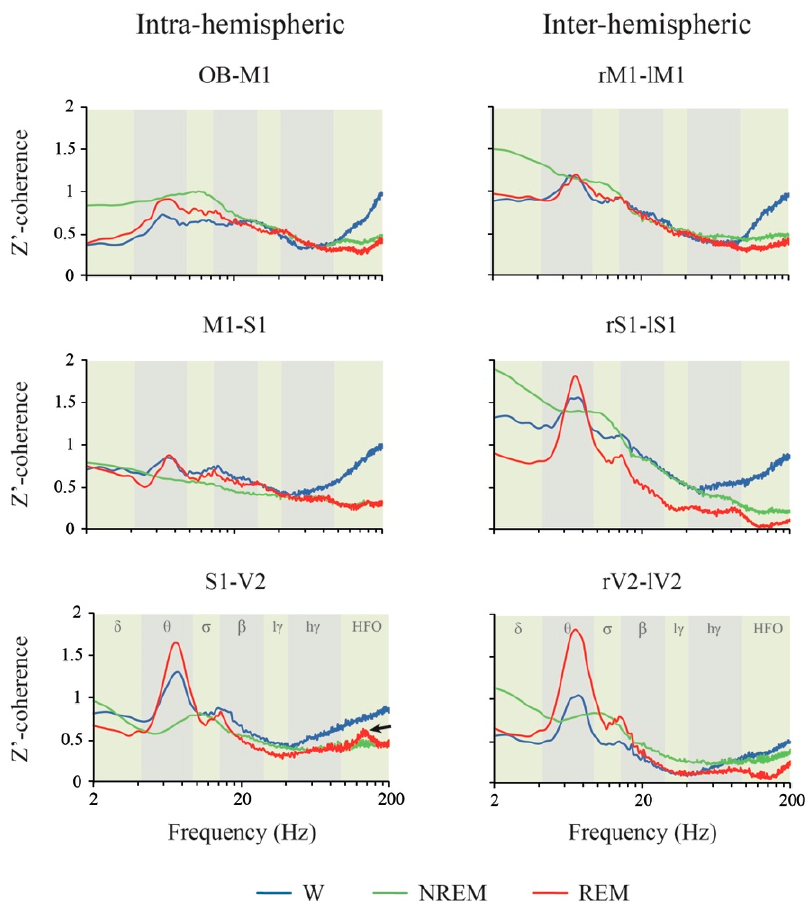
Figure 6. Z’-coherence. Mean z’-coherence profile of the inter-hemispheric and intra-hemispheric derivations (between adjacent areas) during wakefulness (W), NREM and REM sleep in the light phase ( n = 11). The analyzed frequency bands are indicated by di ff erent colors in the background of the graphics. OB, olfactory bulb; M1, primary motor cortex; S1, primary somato-sensory cortex; V2, secondary visual cortex; r, right; l, left; l γ , low gamma or LG; h γ , high gamma or HG; HFO, high frequency oscillations.